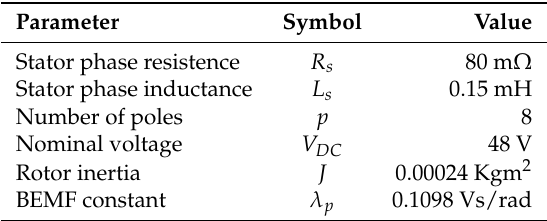
Table 1. BLDC Motor